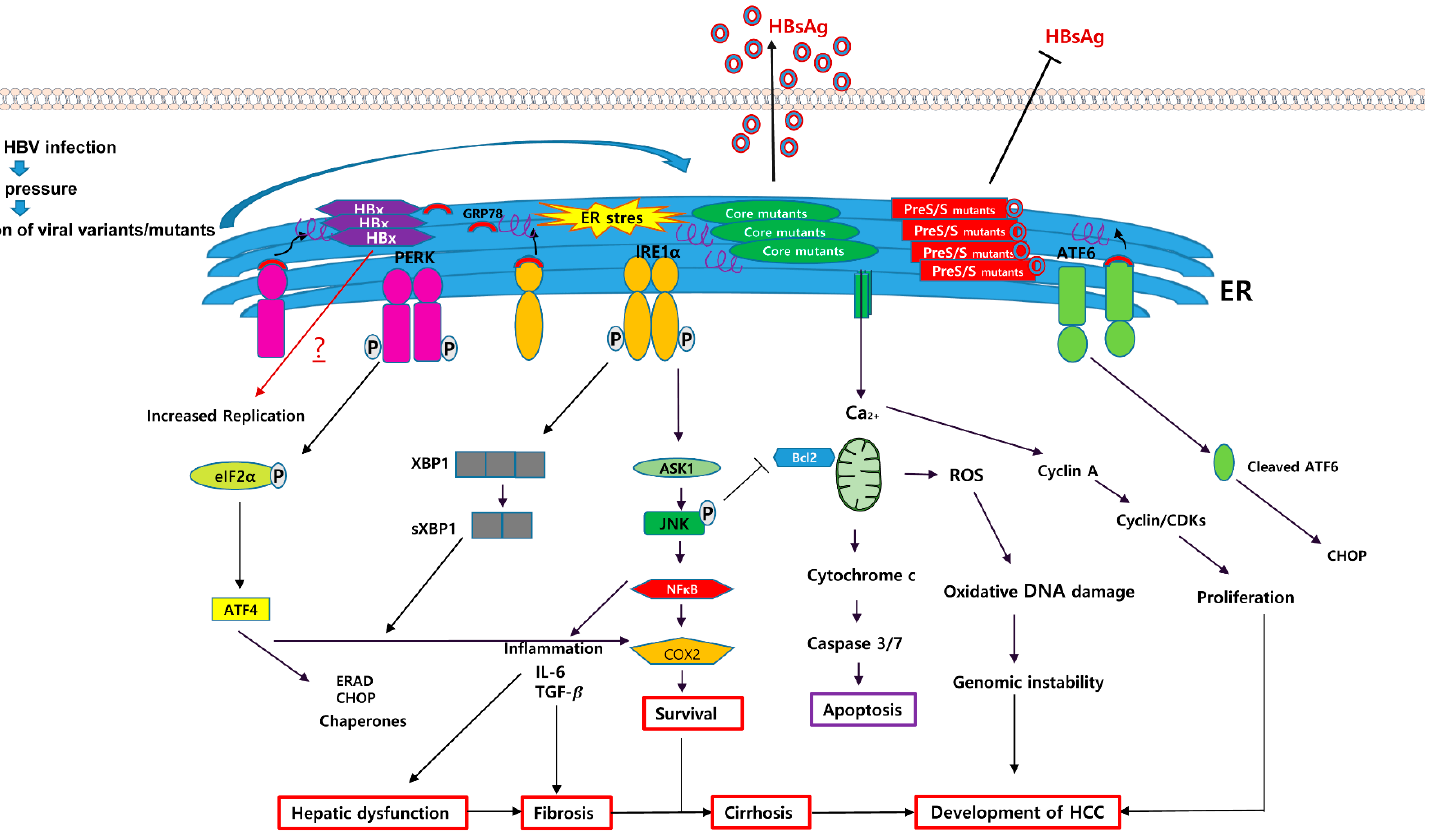
Figure 2. Schematic pathway for ER stress-mediated HCC generation caused by several types of HBV variants such as preS/S, core mutants, and HBx proteins. Naturally occurring mutant HBV proteins, which are caused by immune pressure during chronic HBV infection, including HBsAg, MHBs, LHBs, and HBcAg, could accumulate in the ER and induce ER stress. The HBsAg, MHBs, and LHBs variants could lead to defective HBsAg secretion due to disturbance of the ratio between LHBs and HBsAg. Meanwhile, HBcAg variants could increase the capacity of HBsAg secretion, which may be due to activation of the S promoter via ER stress, and induced ER stress could activate three different UPR transducers: PERK, IRE1, and ATF6. Generally, ER stress-mediated UPRs could contribute to HCC generation in chronic HBV patients via distinct biological actions including ROS production, inflammation, apoptosis, and the activation of NF- κ B. Black arrows indicate positive regulation. T-bars indicate suppression. The red arrow implies an unknown consequence of ER stress yet via HBV genome mutation for the progression of HCC. HBsAg, hepatitis B virus surface antigen; MHBs, hepatitis B middle surface protein; LHBs, hepatitis B large surface proteins; HBcAg, hepatitis B core antigen.